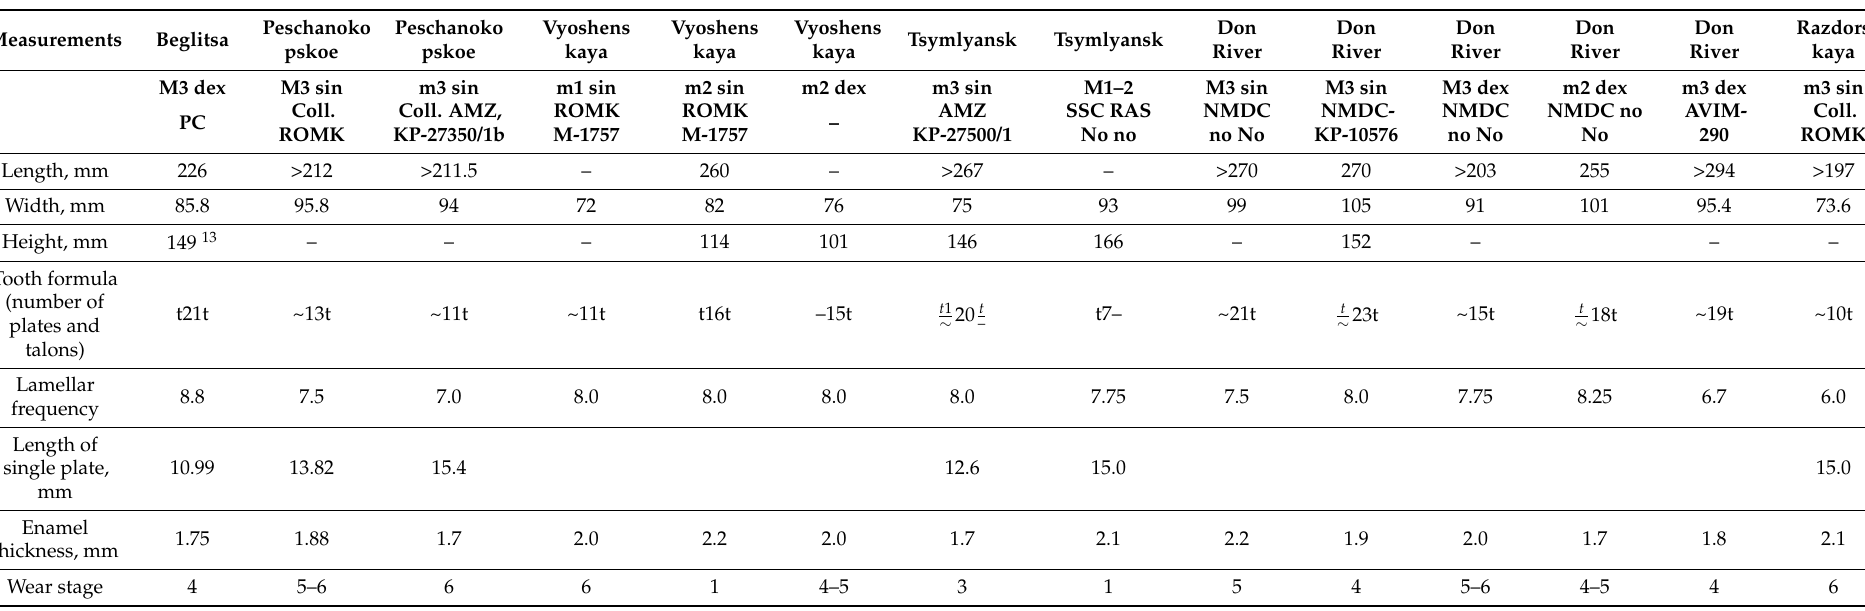
Table 6. Measurements of Mammuthus intermedius teeth from different localities of the Lower Don Region (Southern Russia). t—talon, ~—worn plates, —–damaged plates and t 1 ∼ 20 t —restored plates, superscript (for example, 13 ) – the number of measured